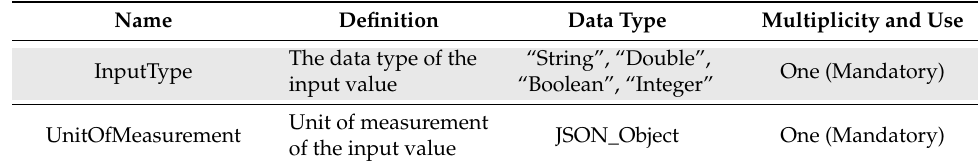
Table 4. Properties of the Definition .